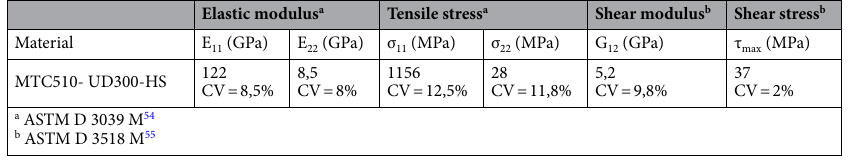
Table 1. Mechanical properties of the substrate